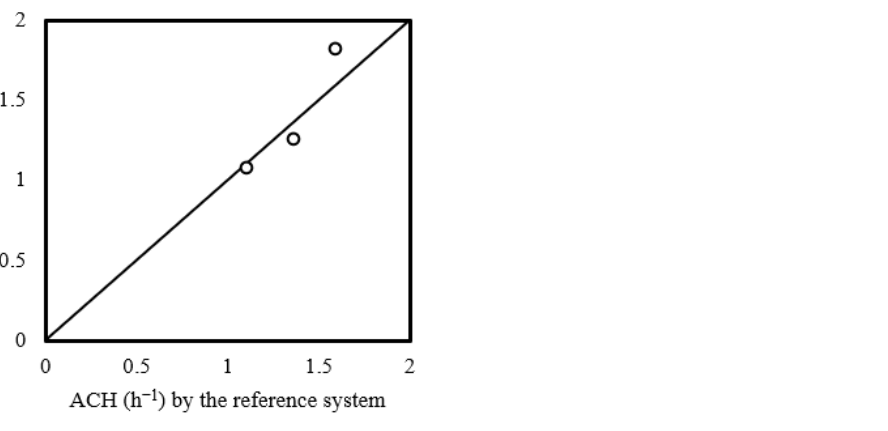
Figure 7. Air change rates (ACHs) evaluated using data collected by the novel system against the reference system under three ventilation schemes.